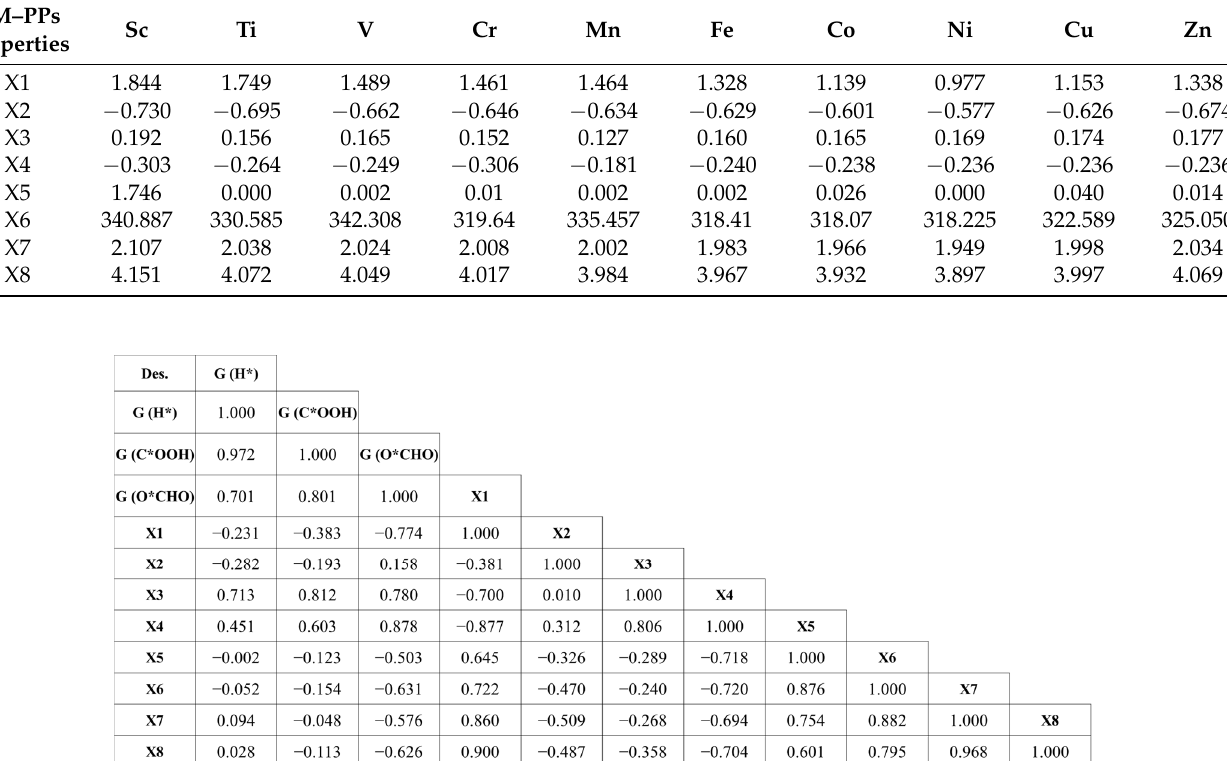
Figure 3. The optimized structure of the transition-metal–porphyrin complexes and the definitions of the structural and electronic properties (TM–PPs, TM = Sc, Ti, V, Cr, Mn, Fe, Co, Ni, Cu, and Zn). The white, gray, blue, and pink colors represent H, C, N, and TM atoms, respectively. Table 1. Structural and electronic properties of transition-metal–porphyrins (TM–PPs).